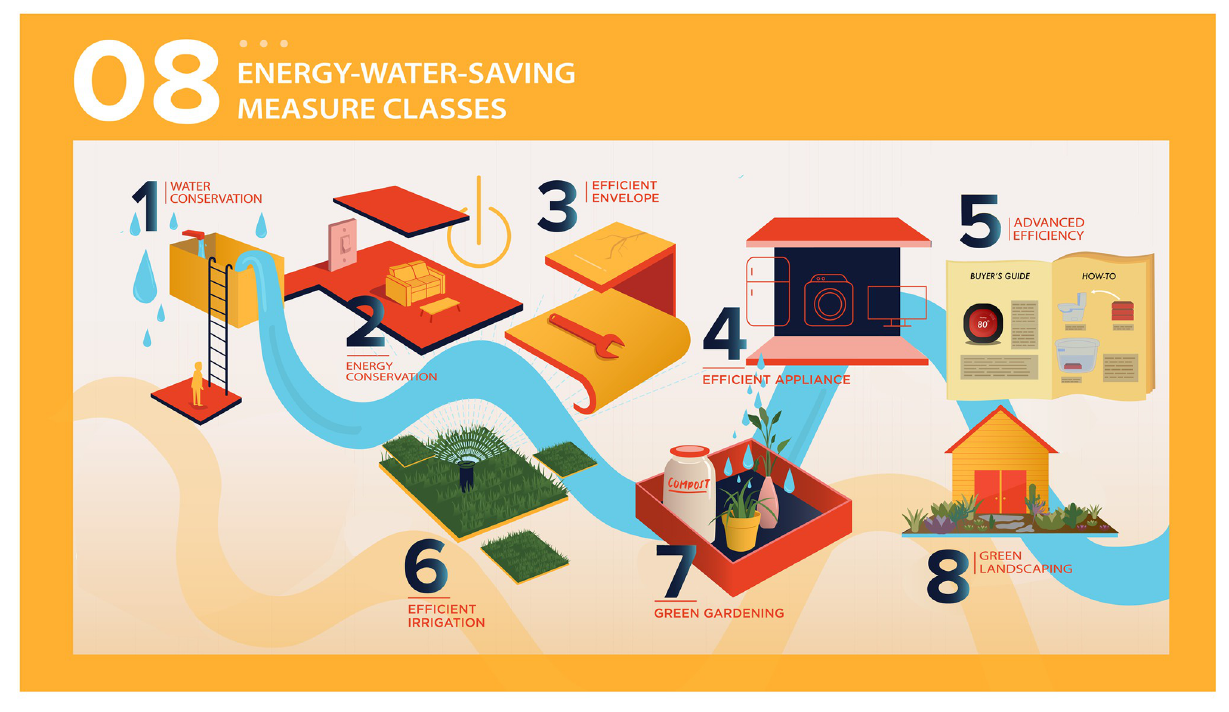
Fig 1. Illustration of identified measure classes.